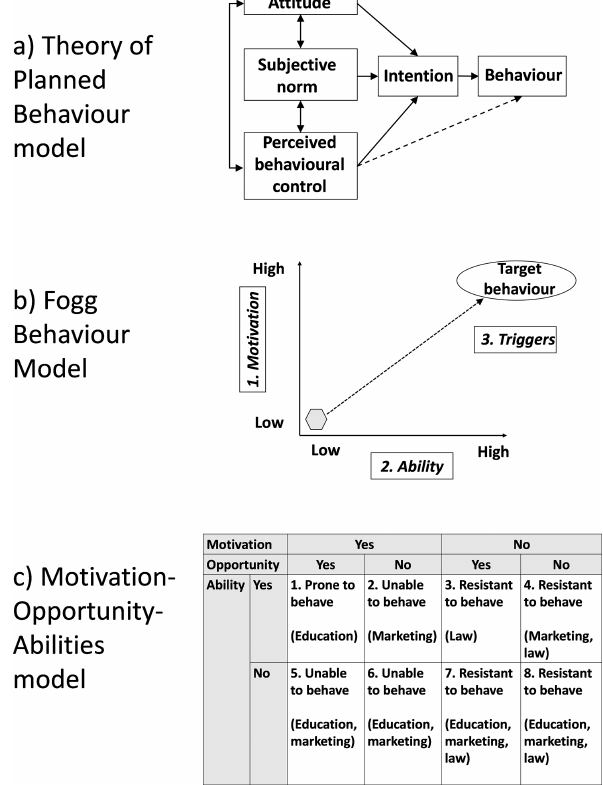
Figure 2. The (a) theory of planned behaviour model (TPB; adapted from Ajzen, 1991), (b) Fogg behaviour model (FBM; adapted from Fogg, 2009) and (c) motivation–opportunity–ability model (MOA; adapted from Rothschild, 1999). The TPB proposes that the fac- tors influencing an intention to perform a behaviour comprises the attitude towards the behaviour, the subjective norm(s) relating to the behaviour and perceived behavioural control. The FBM argues that behaviour is influenced by motivation, ability and triggers. The MOA, on the other hand, asserts that motivation, opportunity